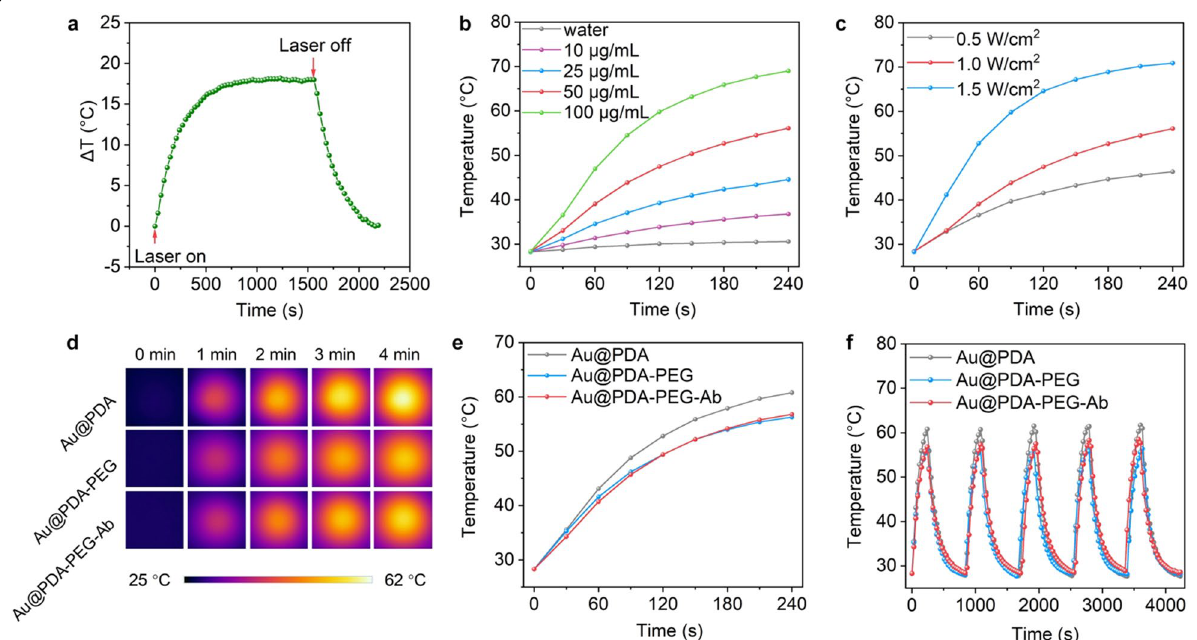
Fig. 3 Photothermal performance of Au nanoparticles. a Temperature curve of Au@PDA-PEG-Ab solution (50 μg/mL, 2 mL) irradiated with a 1064-nm laser at a power density of 1.5 W/cm 2 . The laser was shut off after 30 min of irradiation. b Temperature curves of aqueous dispersion (100 μL) of Au@PDA-PEG-Ab at different concentrations from 10, 25, and 50 to 100 μg/mL under NIR-II laser irradiation (1.0 W/cm 2 ). c Temperature curves of Au@PDA-PEG-Ab solution (50 μg/mL) under NIR-II laser irradiation at different power densities (0.5, 1.0, and 1.5 W/cm 2 ). d Infrared thermal images of aqueous dispersion of Au@PDA, Au@PDA-PEG, and Au@PDA-PEG-Ab (50 μg/mL) upon NIR-II irradiation for 4 min. e Temperature curves of solutions in d . f Photothermal stability of Au@PDA, Au@PDA-PEG, and Au@PDA-PEG-Ab after 5 on/off cycles of laser irradiation (1.0 W/cm 2 ). The concentration of nanoparticle dispersion was 50